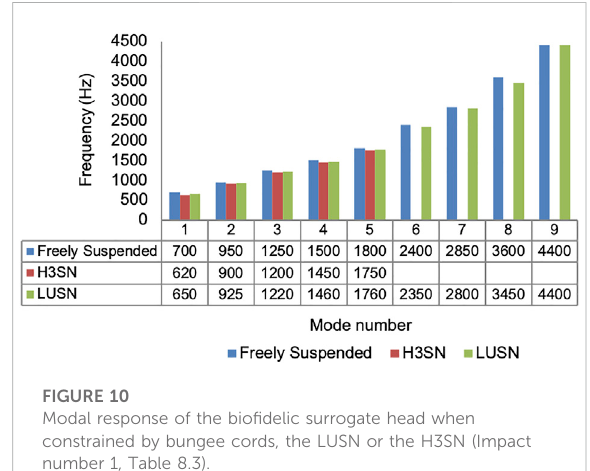
Modal response of the bio fi delic surrogate head when constrained by bungee cords, the LUSN or the H3SN (Impact number 1, Table